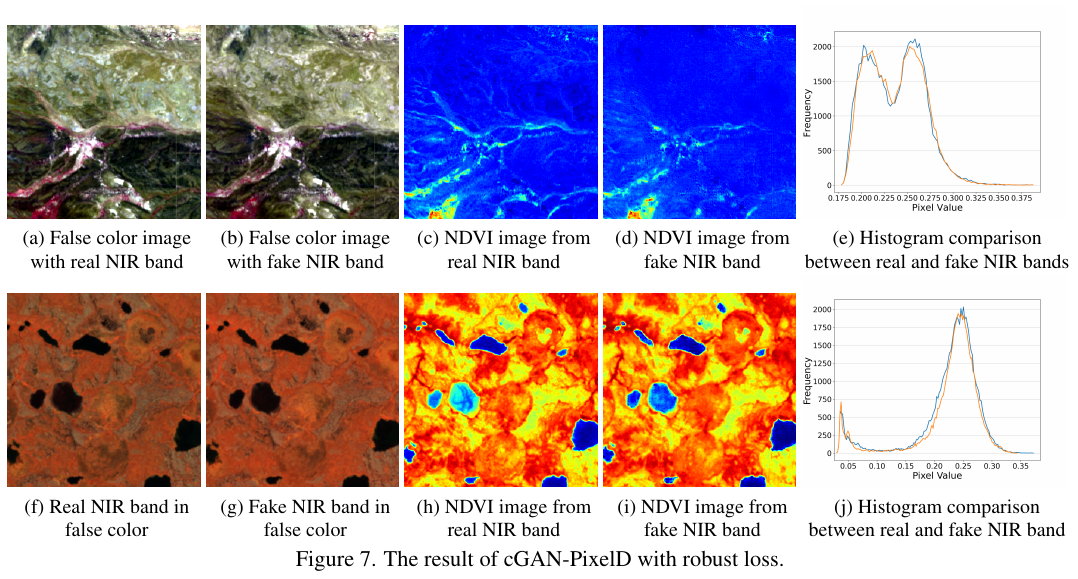
Figure 6. The result of cGAN-PatchD with l1 loss.